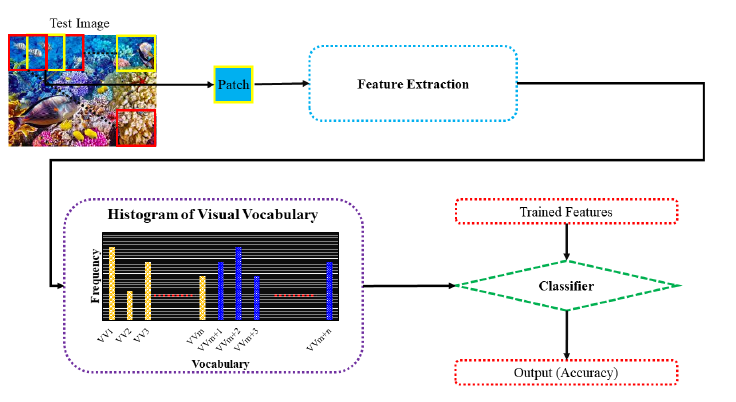
Figure 3. The proposed framework steps visual